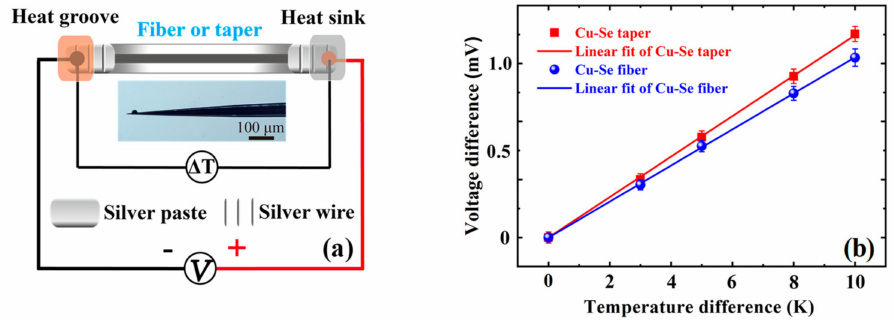
Figure 4. ( a ) Schematic of an electrical circuit connecting the two ends of a fiber or a micro–nano taper; the inset of ( a ) is the optical micrograph of a Cu-Se taper. ( b ) The thermoelectric voltages at temperature differences of 0 K, 3 K, 5 K, 8 K, or 10 K cross the two ends. The error bar in ( b ) shows 5% measurement